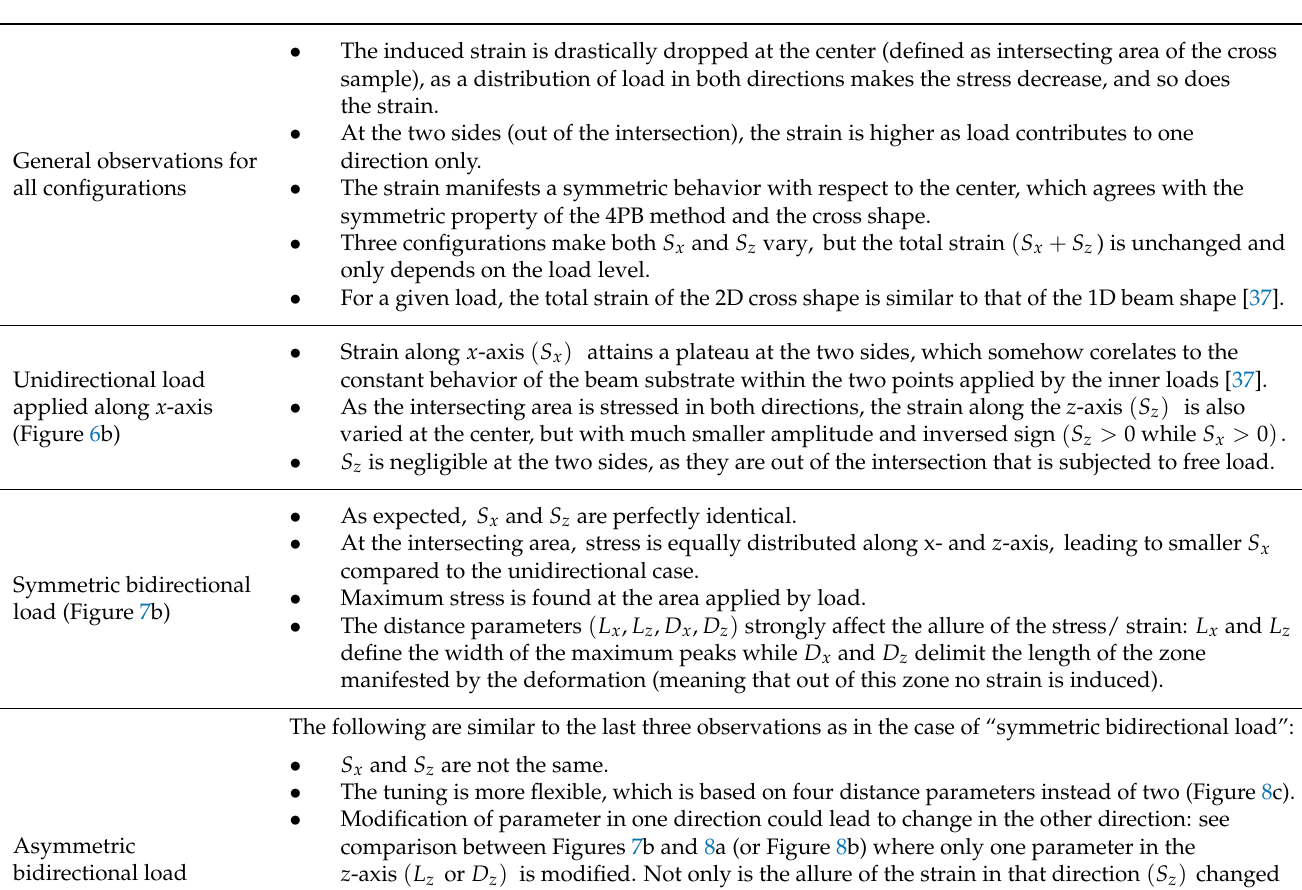
Figure 9. Comparison of the output voltage between experiment and simulation. Table 2. Mechanical behavior of the cross substrate under three different configurations of the 4PB